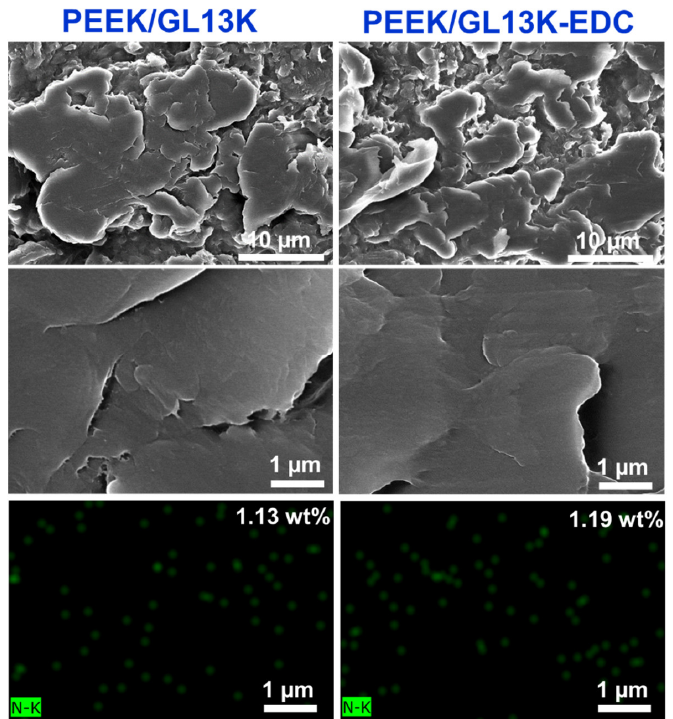
Figure 7. FESEM micrographs (first two rows) and nitrogen mapping derived from EDX mapping (bottom row) of the GL13K released from the PEEK/GL13K and PEEK/GL13K-EDC samples after 24 h of immersion in DI water.